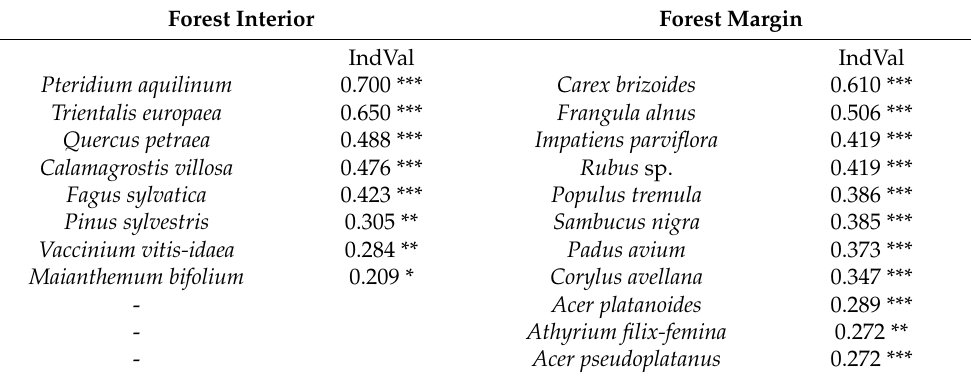
Table 3. Lists of species relative to their preferences of occurrence found during the